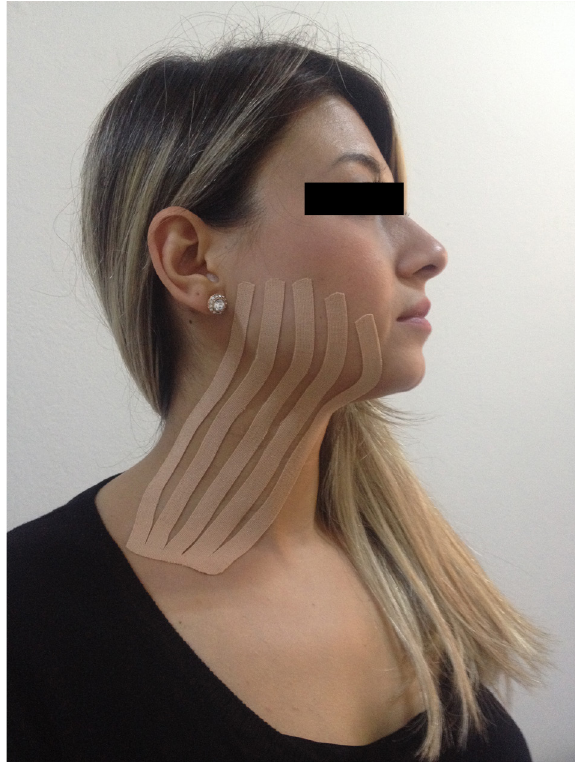
Figure 1- Clinical application of kinesio